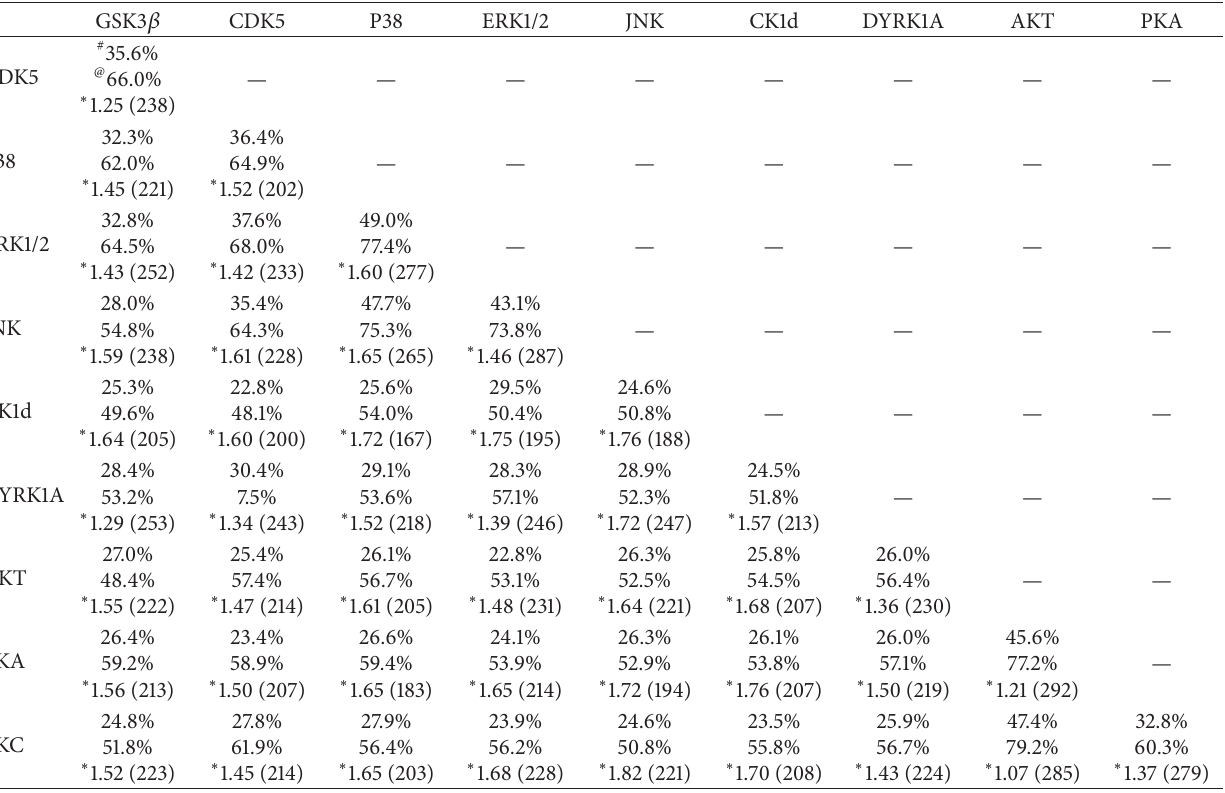
Table 2: Percentage identity, similarity, and RMSD values (for the overlapping number of atoms).